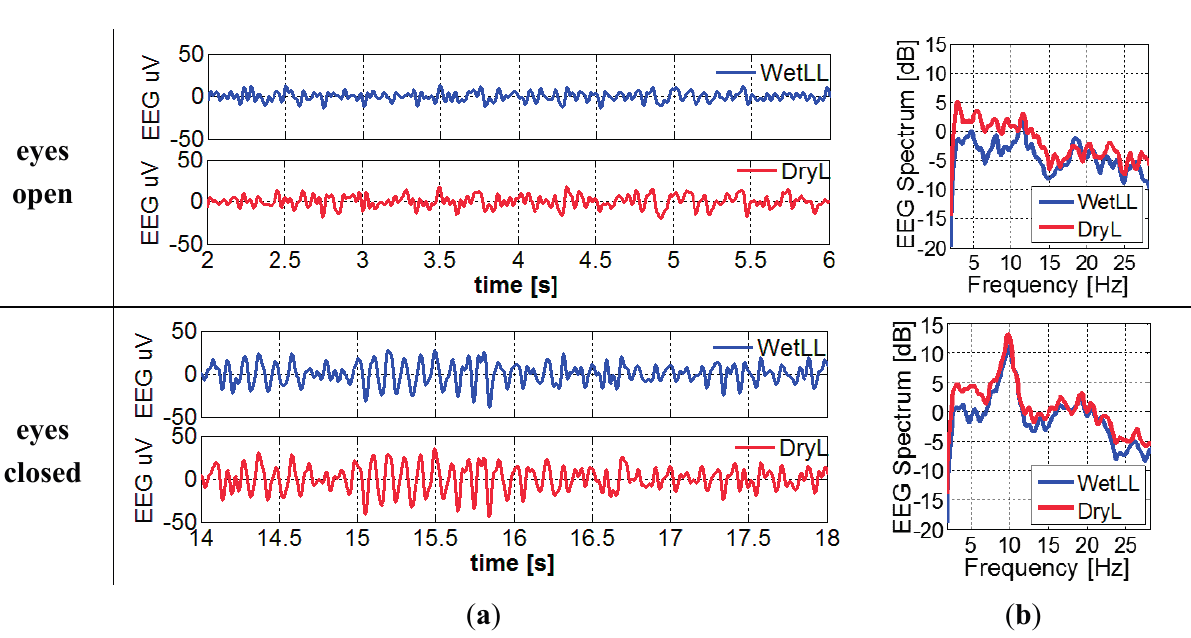
Figure 10. ( a ) Filtered EEG signals; ( b ) EEG spectrum of wet and dry electrodes when the eyes of subject were open and